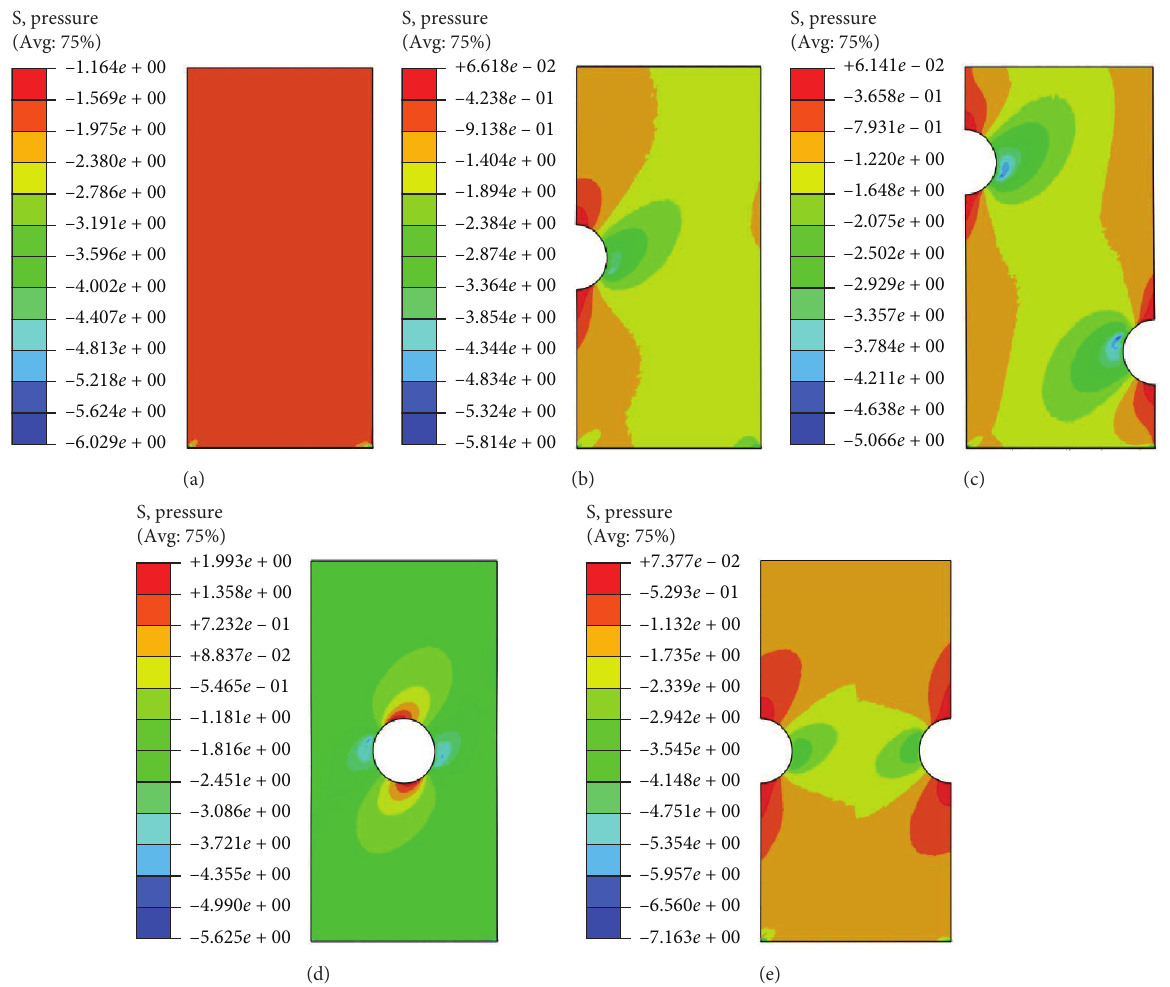
Figure 13: Hydrostatic stress distribution (described by “pressure” in ABAQUS) for five samples in tension. (a) ε � 1.0%, smooth specimen; (b) ε � 1.0%, specimen A; (c) ε � 1.0%, specimen B; (d) ε � 1.0%, specimen C; (e) ε � 1.0%, specimen D, in which, the unit of pressure is actually denoted as σ / σ in which σ is 225MPa (according to the deduction process in hydrostatic 0 0